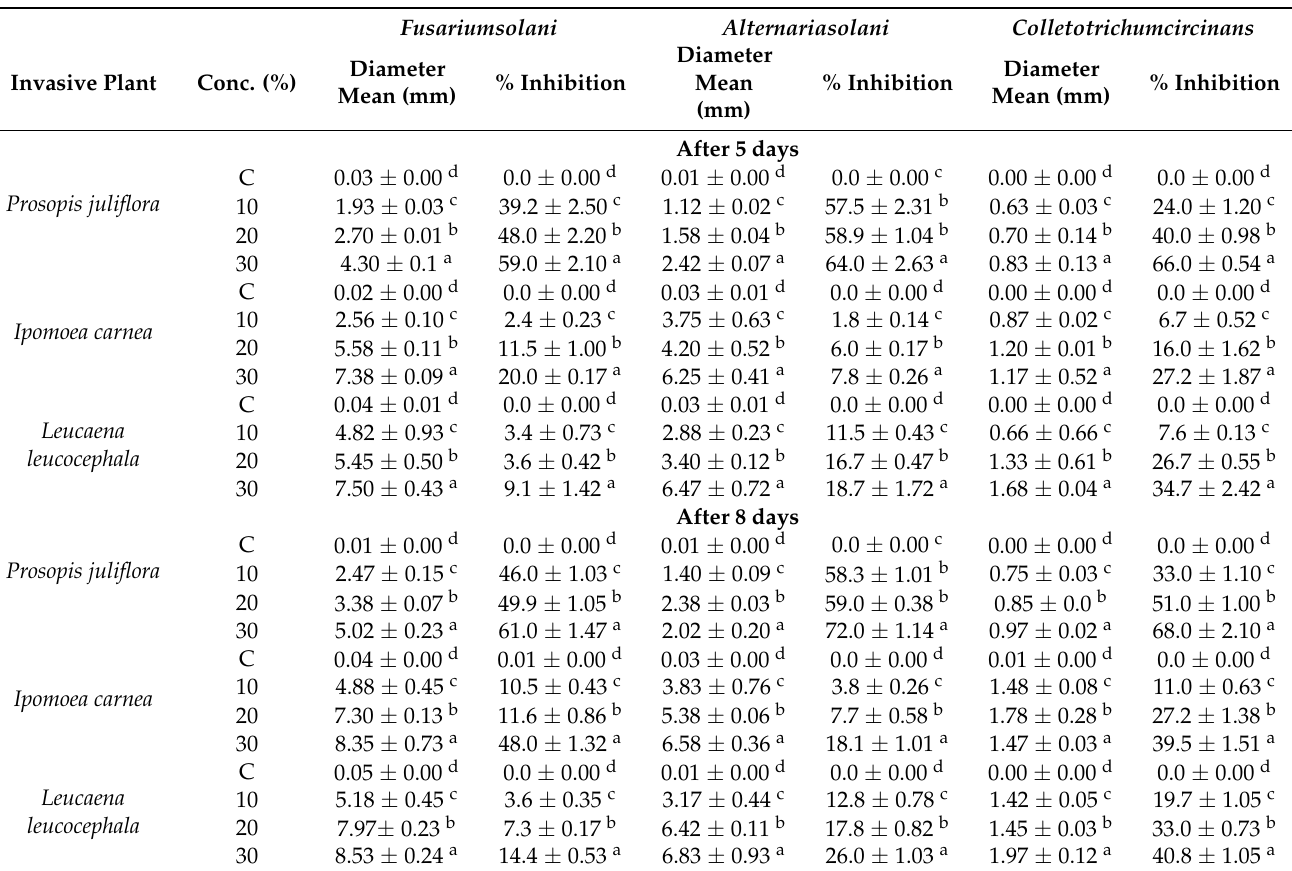
Table 2. Diameter of mycelial growth and percent of radial growth inhibition of Fusarium solani , Alternaria solani , and Colletotrichum circinans after 5 and 8 days of treatment, under in vitro conditions. Letters indicate statistically significant treatment effects after post-hoc Bonferroni